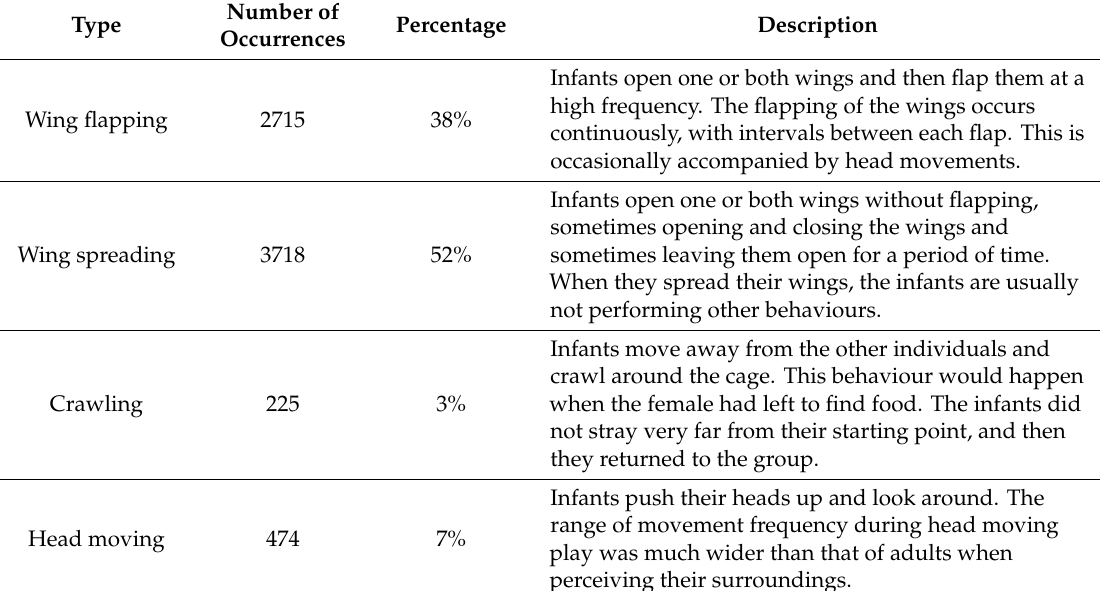
Table 2. Description of the behaviours (ethogram) recorded in Asian parti-coloured bat infants. Number of Type Percentage Description Occurrences